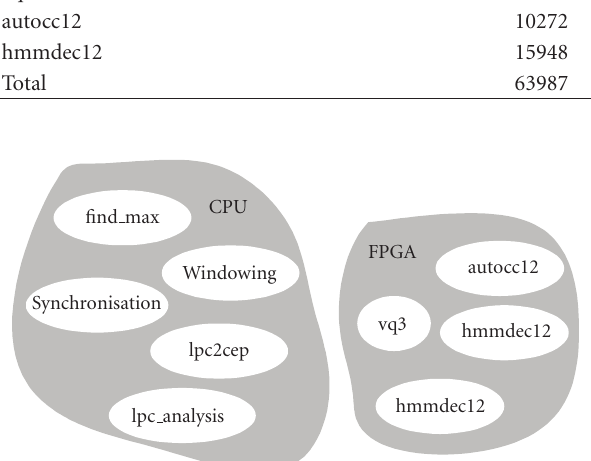
Figure 7: Mapping the speech recognition system to the hetero- geneous computing system. “vq3” are the unrolled 3 iterations of vector quantisation. “autocc12” are the unrolled 12 iterations for autocorrelation. “hmmdec12” are the unrolled 12 iterations for HMM decoding. Two “hmmdec12” mean the outer loop of HMM decoding is unrolled for 2 iterations, that is, decoding of two words is executed in